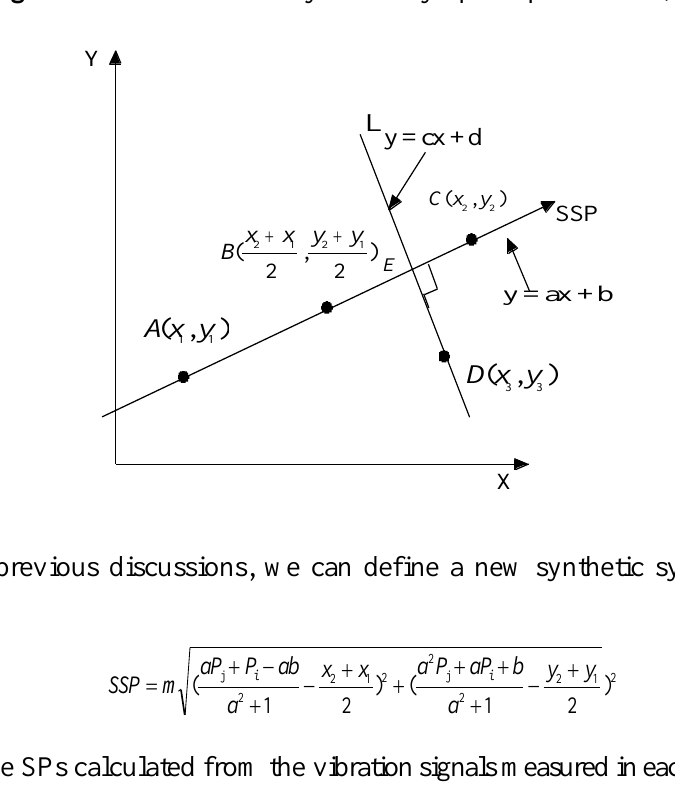
Figure 3. The axis of the synthetic symptom parameter